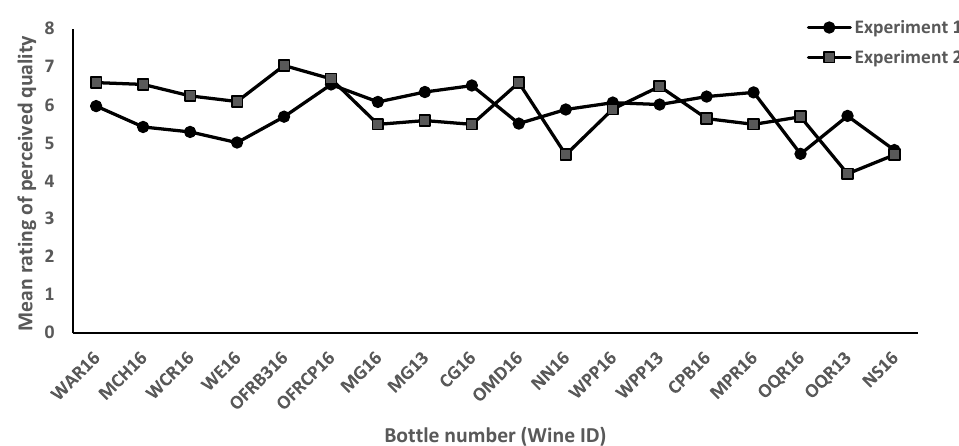
Figure 4. Mean ratings of perceived wine quality obtained in Experiment 1 and Experiment 2 for the same set of 18 wines. Experiment 1 investigated primarily aromatic attributes, whilst Experiment 2 investigated in-mouth attributes of taste and trigeminal effects (mouthfeel). The perception of the quality in the wines was highly and positively associated with perceived varietal typicality, a concept that refers to whether a Pinot noir wine ex ‐ emplifies a taster’s concept of what a Pinot noir wine should be like. (i.e., is the wine true to grape type?)